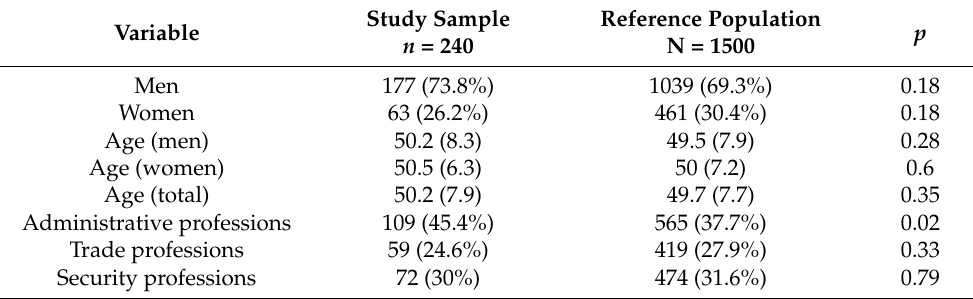
Table 1. Characteristics of sample and comparison with reference